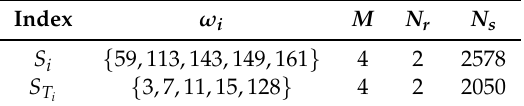
Table A2. The values used for sensitivity